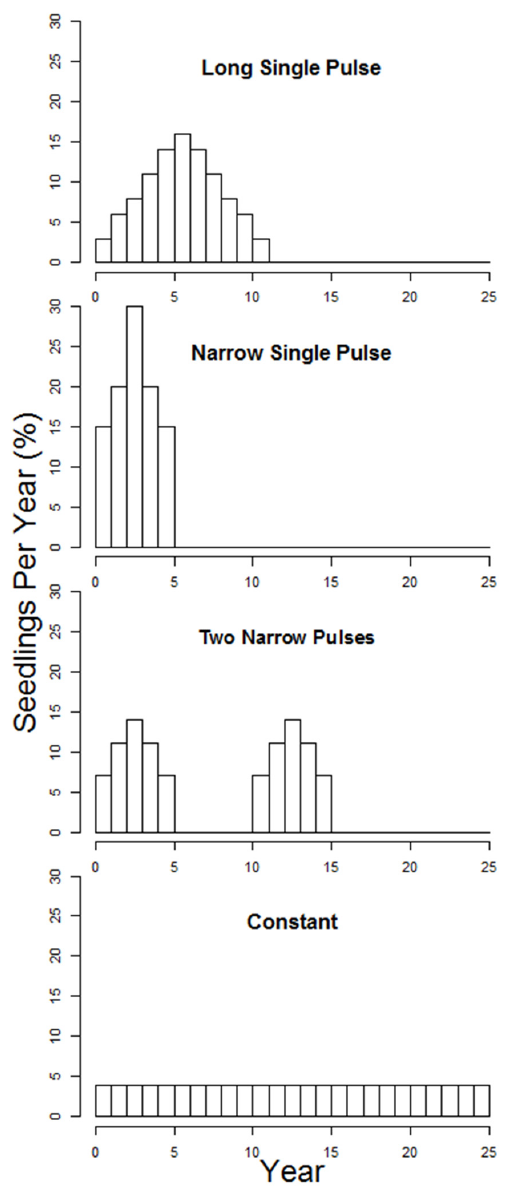
Figure 2. Temporal distribution of natural regeneration simulated in each post ‐ treatment stand.